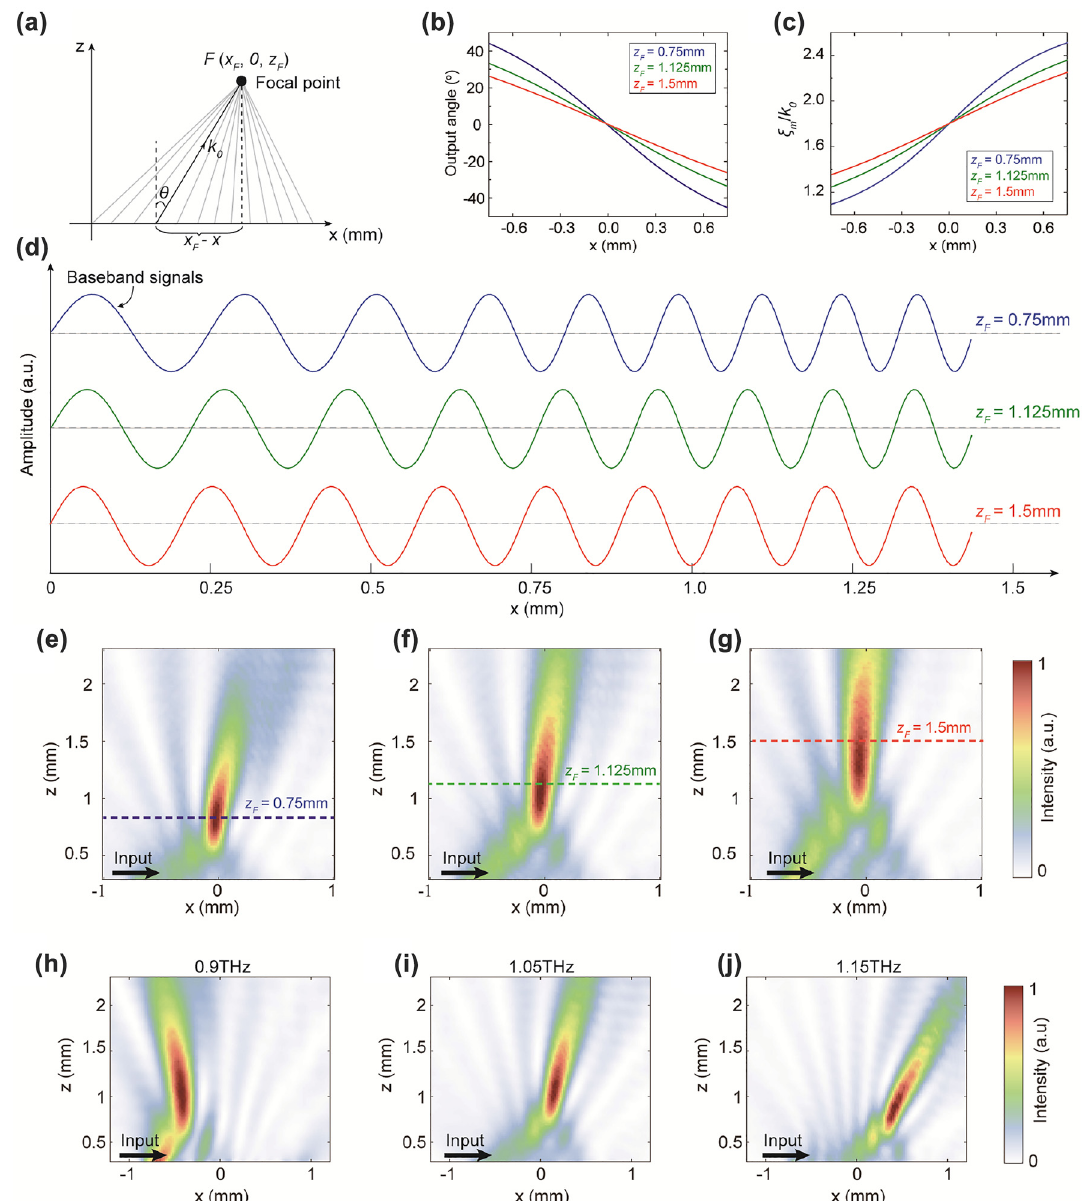
Figure 5: Light focusing flexibility of the superheterodyne metasurface. (a) Geometric representation of the light-focusing metasurface. The superheterodyne metasurface is located at z = 0, and the target focal point is at F ( x light along the metasurface aperture when the target foci are F ( x (c) The corresponding spatial frequencies of the baseband signals along the metasurface aperture for different target foci. (d) The corresponding baseband signals for generating different target foci. (e to g) The corresponding simulated intensity distributions for different focusing cases at 1 THz. The dashed lines depict the theoretical vertical levels of the focus point. (h to j) Simulated intensity distributions of the superheterodyne metasurface at 0.9, 1.05, and 1.15 THz,